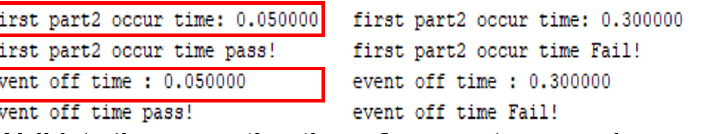
Figure 15. Pass/fail is determined based on the generation time of BSM before and after the occur- rence of the event of the terminal node of the evaluation. In this figure, the time taken from generation to reception of part II data is measured and displayed, and result is "pass" if transmitted within 50 ms. And, if the occurrence time of part II event ends is within 250 ms (vEventDetectLatency), the result is "pass".